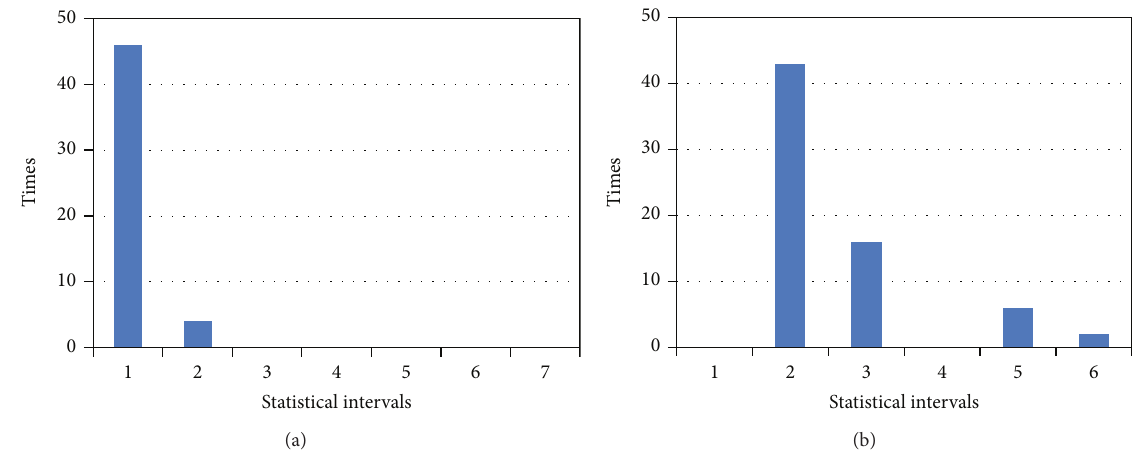
Figure 12: (a) Packet protocol type statistical histogram; (b) TCP control the field statistical histogram